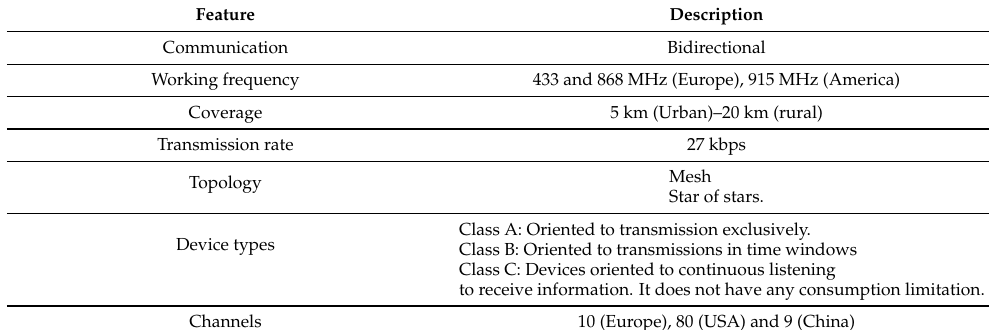
Table 4. Main characteristics of LoRa